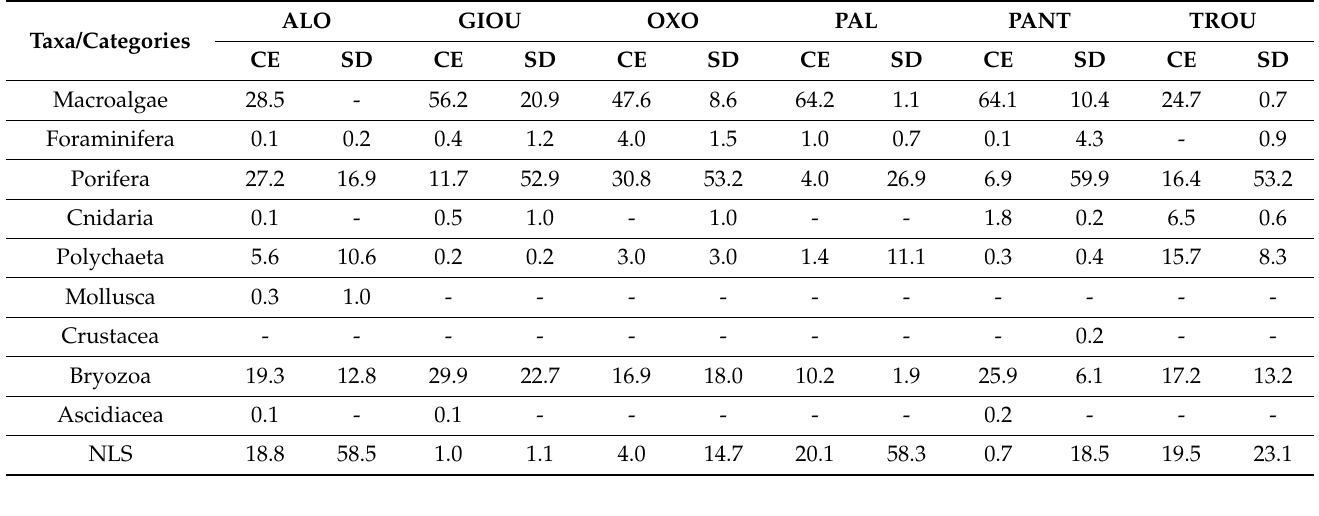
Table 2. Summary data with the average percentage of coverage (%) of all groups of sessile taxa and non-living substrate for each ecological cave zone. ALO: Alona, GIOU: Giourious, OXO: Oxonisos, PAL: Palatia, PANT: Panteleimonas, TROU: Troulakas, CE: entrance zone, SD: semi-dark zone, NLS: Non-living substrate.